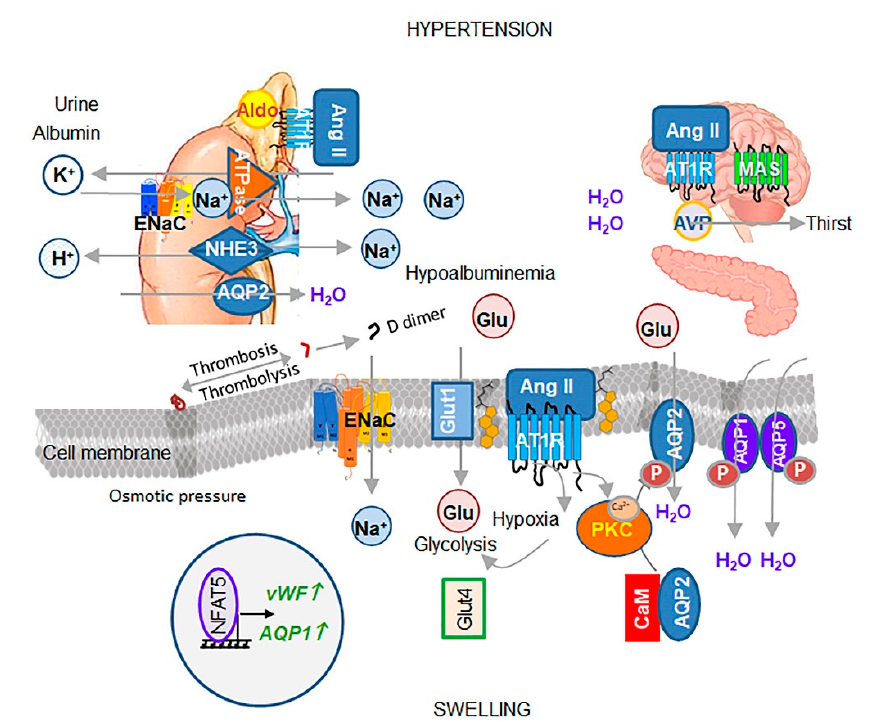
Figure 3. The principal components of osmotic regulation by Ang II (ACE2 OFF). In the cholesterol-rich membrane (yellow structures) of barrier cells (specified below), Ang II / AT1R activates classical and novel protein kinase C (PKC) and mobilizes Ca 2 + from internal stores. Ca 2 + binds to calmodulin (CaM), resulting in disassembly of AQP2 and CaM complex retaining AQP2 in the cytosol of cells expressing AQP2 (cortical and medullary renal collecting ducts, pancreatic islets, fallopian tubes, peripheral nerves [33], as well as lymphatic endothelium [34]). PKC phosphorylation of AQP2 (P-AQP2) and Ca 2 + -activated cytoskeleton translocate to membrane P-AQP2 for stimulated water influx. Epithelial